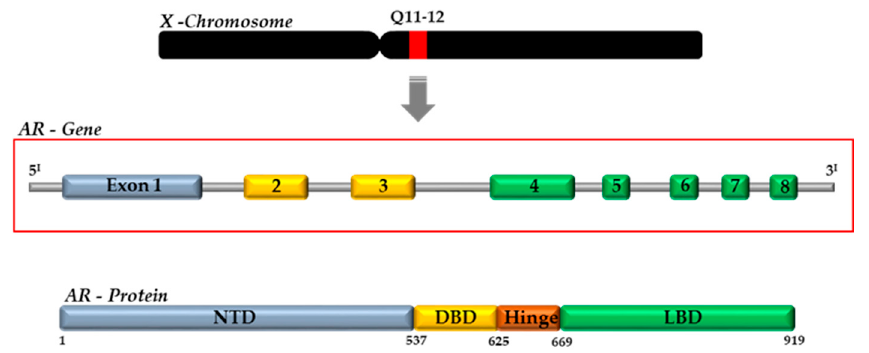
Figure 2. Schematic representation of AR gene and protein, with specific motifs and domains. NTD, N-terminal domain; DBD, DNA-binding domain; LBD, ligand-binding domain; AF, activation func- tion.